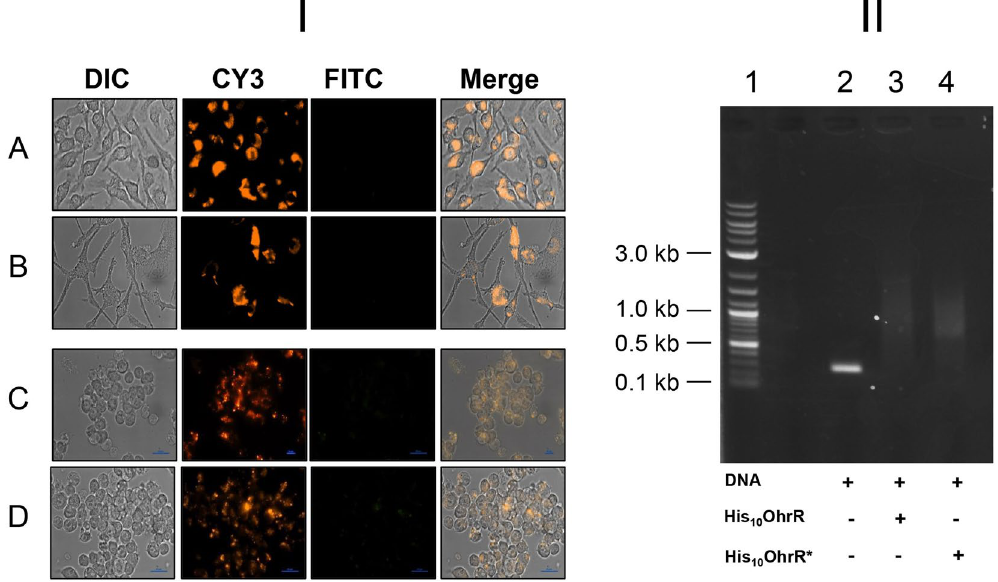
Figure 7. M . smegmatis strain MSOHG5 bearing Cys mutated OhrR shows no GFP induction. I. MSOHG5 in the intracellular environment. BMDM ( A and B ) and RAW264.7 ( C and D ) cells grown on glass coverslips were infected with M . smegmatis MSOHG5 bearing ohrR * - pohr - gfpuv and phsp60 - rfp fusions for 4 h ( A and C ) and 24 h ( B and D ) at 37 °C. After washing, the coverslips were examined under Nikon TiE Inverted Fluorescence M icroscope using 60X objective. DIC, Cy3 and FITC indicate the images obtained using these filters. MERGE indicates merged DIC, CY3 and FITC images. II. EMSA showing the interaction of recombinant Cys mutated OhrR protein of M . smegmatis with ohr - ohrR intergenic region. EMSA was performed as described in the methods section. Lane 1, DNA Marker; Lane 2, ohr - ohrR intergenic region; Lane 3, ohr - ohrR intergenic region with non-mutated OhrR (MSHis 10 OhrR); Lane 4, ohr - ohrR intergenic region with Cys mutated OhrR (MSHis 10 OhrR *